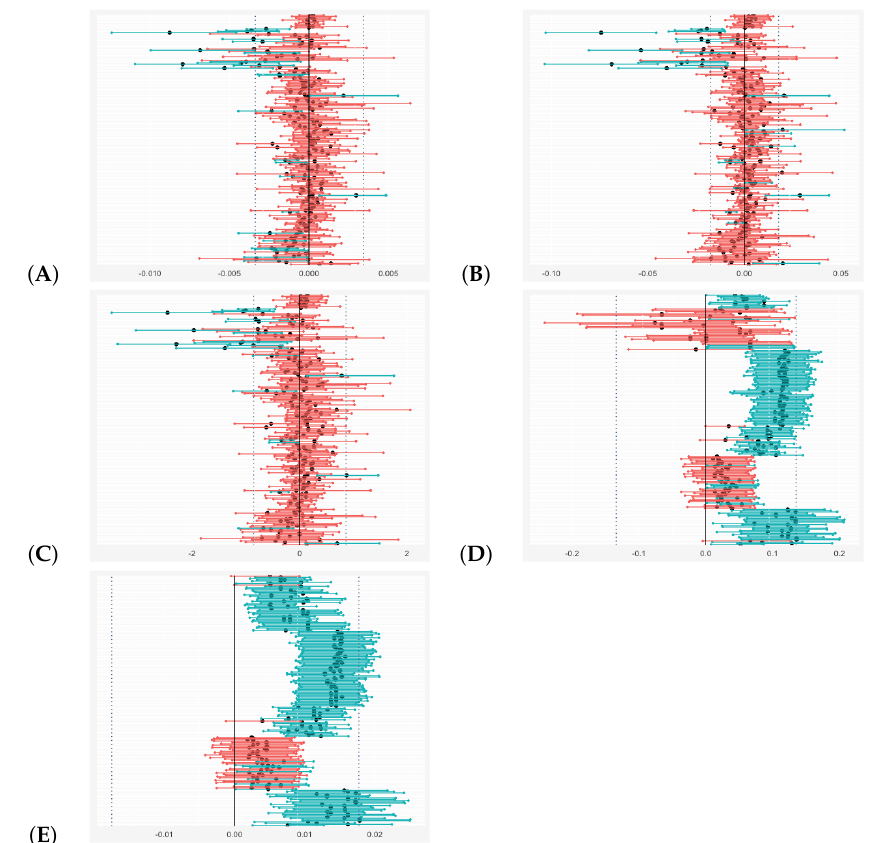
Figure 5. Trend Significance Plots: ( A ) Aridity. ( B ) Runoff. ( C ) Precipitation. ( D ) PET. ( E ) Temperature. Interval plots, where intervals assuming independence are presented in two colors: magenta for those not significantly different from zero and otherwise cyan. Dotted lines in grey are the 95% global confidence interval constructed assuming spatial dependence. Each interval corresponds to a meteorological station in the y-axis, in its order from 1 to 199 (from South to